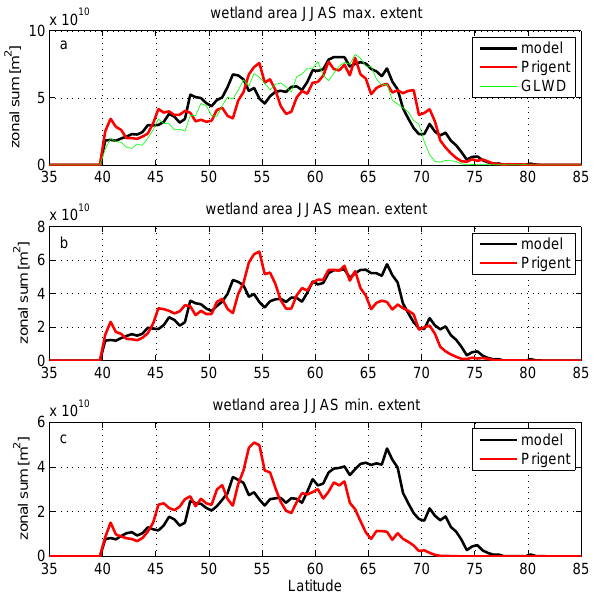
Fig. 2. Zonal sums of modelled wetland extent (black), Prigent et al. (red), and GLWD (green). Upper panel (a) : Summer (JJAS) maximum extent, middle (b) : JJAS mean extent, and lower panel (c) : JJAS minimum extent.